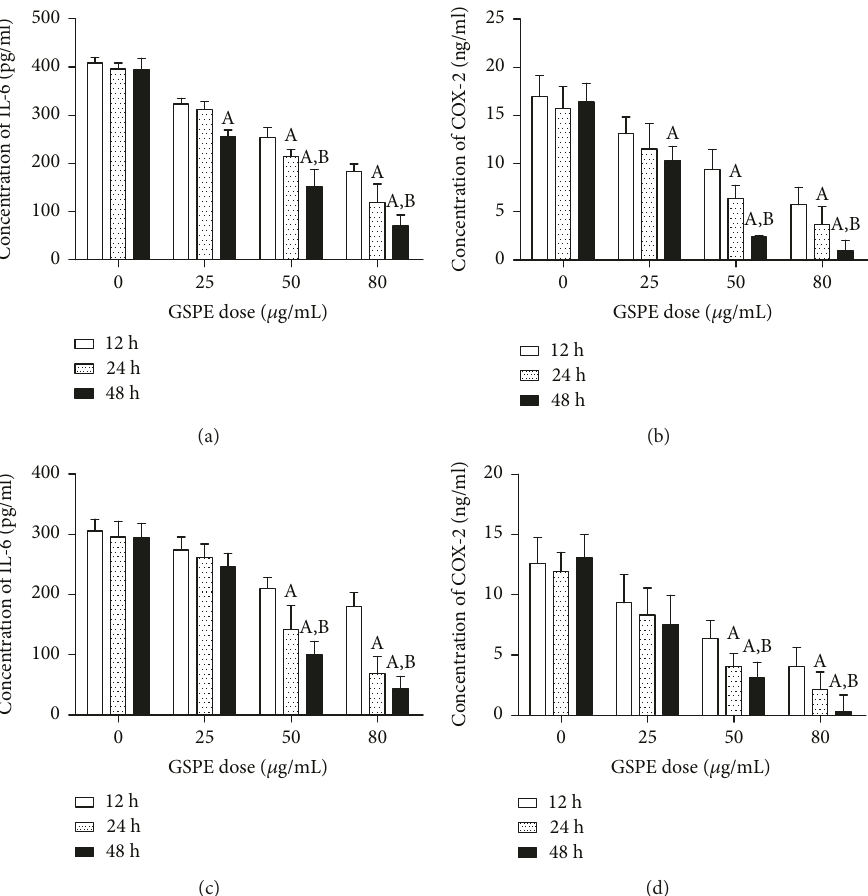
Figure 5: GSPE and BAY11-7082 inhibited the expression of in fl ammatory cytokines IL-6 and COX-2. (a, b) The inhibition of IL-6 and COX-2 in cells induced by GSPE (0 – 80 μ g/mL). (c, d) The inhibition of IL-6 and COX-2 in cells induced by GSPE (0 – 80 μ g/ mL)+BAY11-7082. Each column represents mean ± SD of three groups of independent samples. A P < 0 05 compared with the 12 h group; B P < 0 05 compared with the 24h